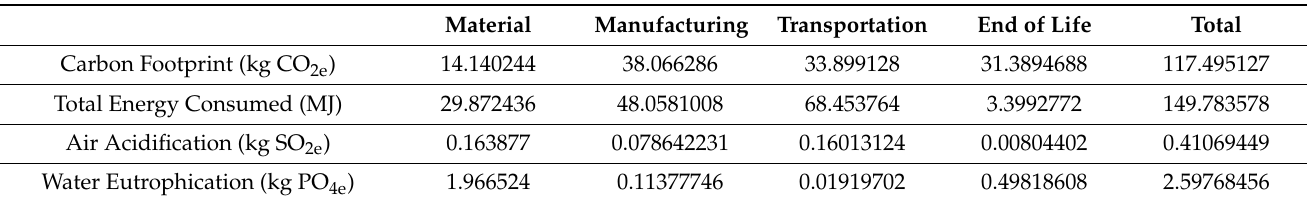
Table 4. Presentation of emissions obtained via LCA analysis for the analysed object for hemp wool with a thickness of 10 cm.